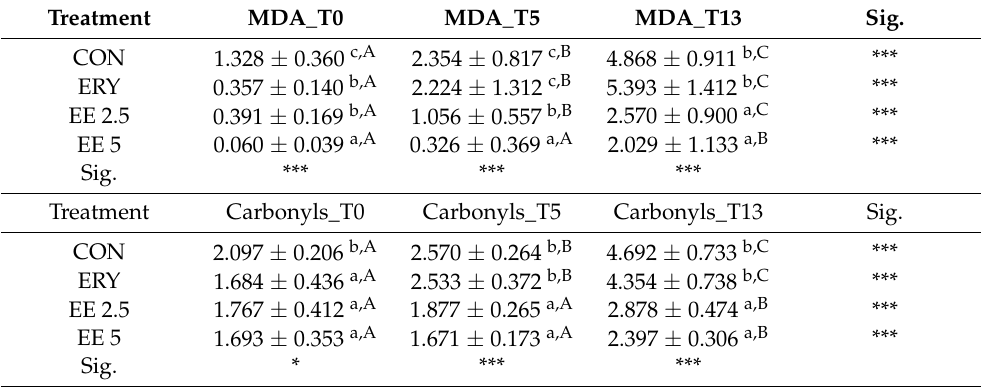
Table 1. Evolution of thiobarbituric acid reactive substances (TBARS) and carbonyl compounds in beef burgers added with EE and ERY during 1 (T0), 5 (T5), and 13 (T13) days of storage.